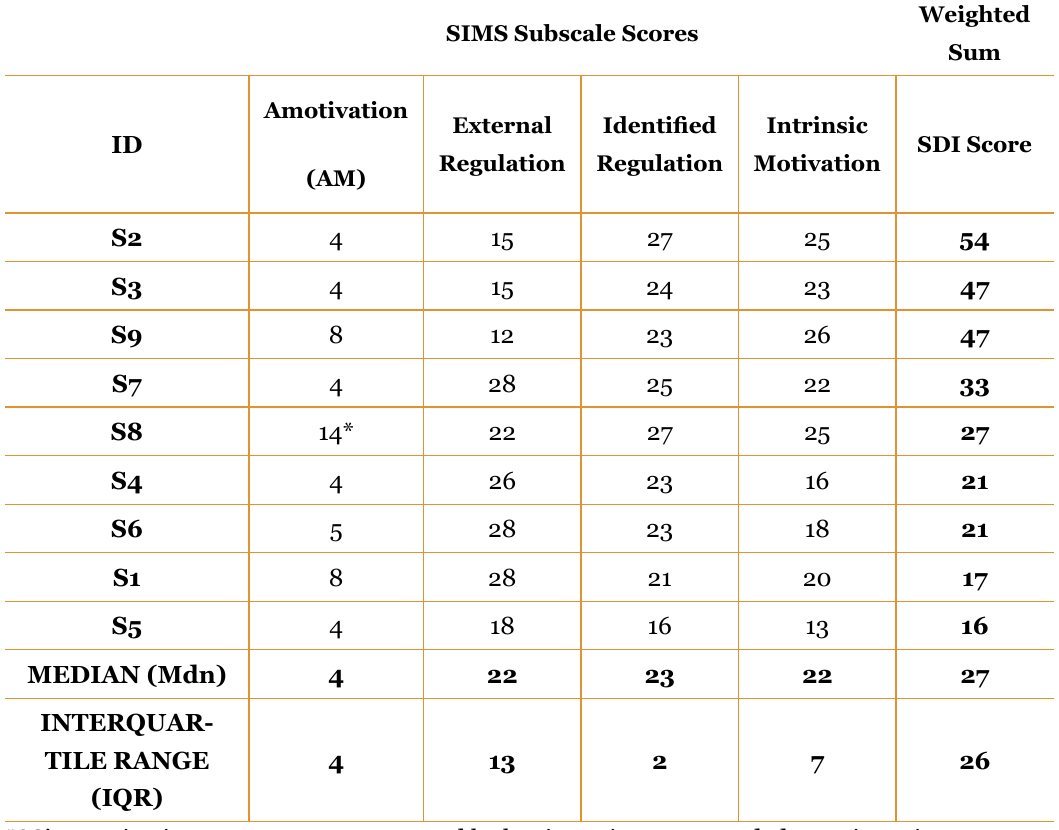
Case Study Two Participants’ SIMS and SDI Scores